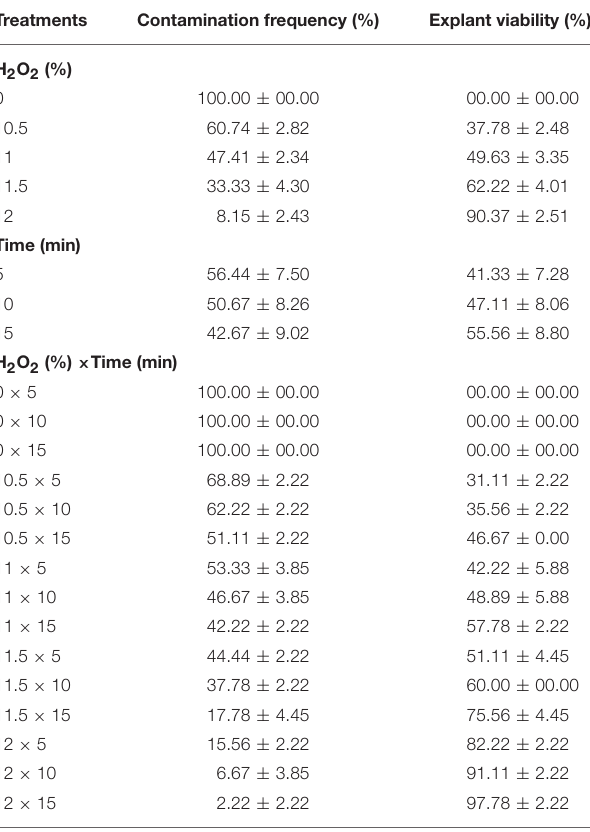
TABLE 5 | Effect of different concentrations of AgNO 3 at various immersion times on in vitro sterilization of chrysanthemum.